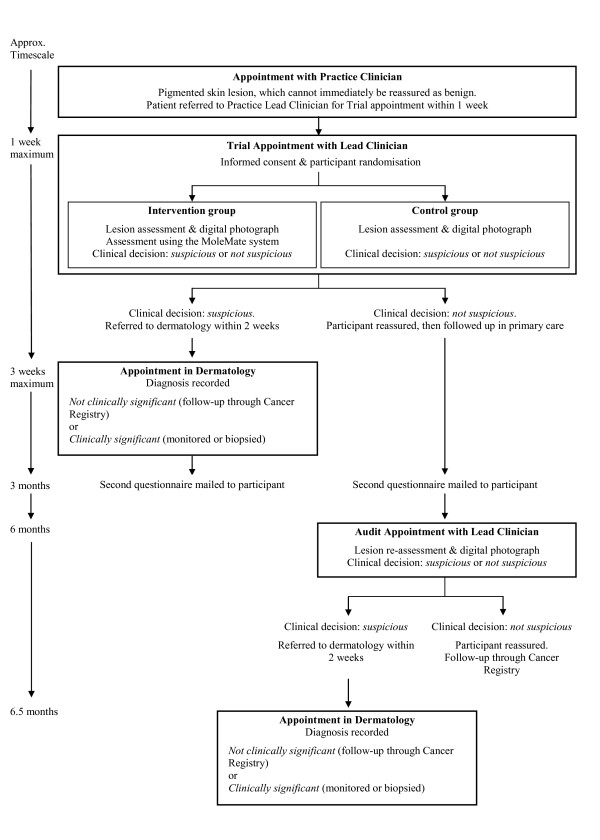
Trial flowchart.